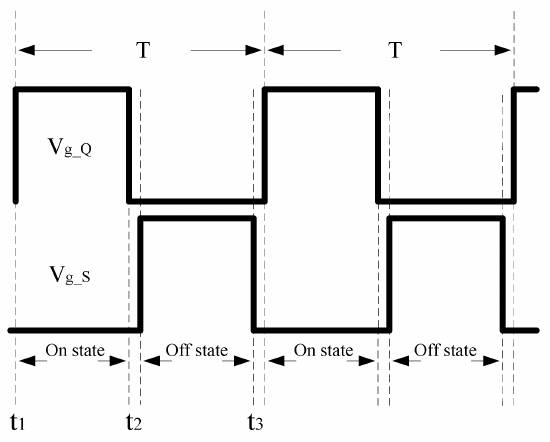
Figure 5. Control signal of the switches.